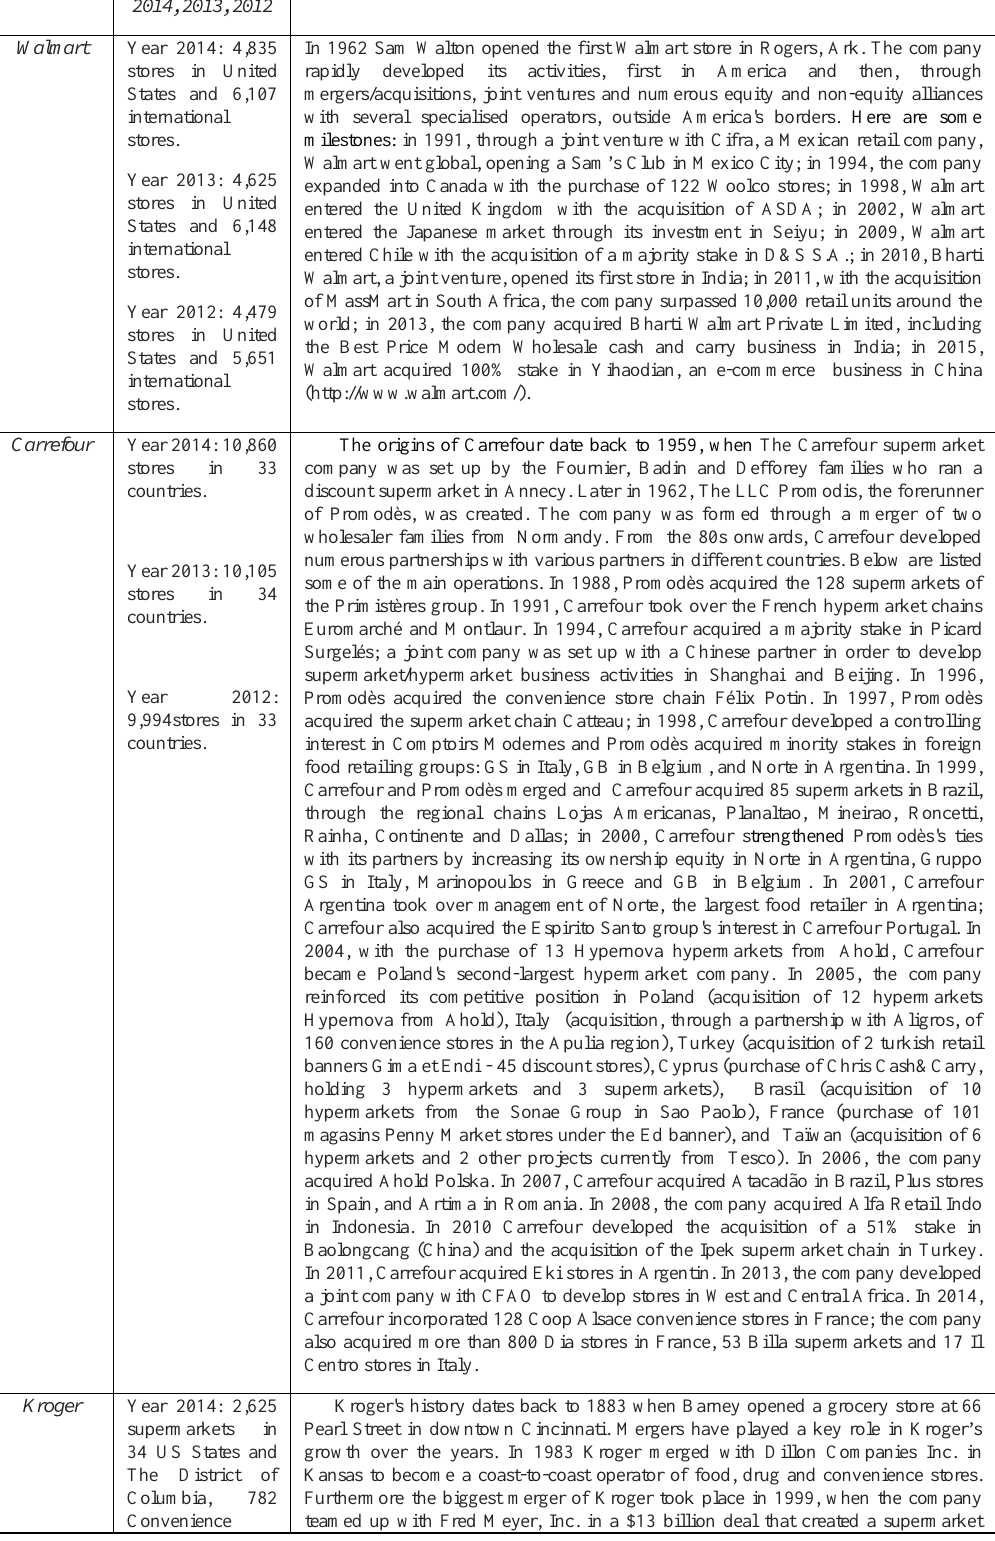
Table 3: Stores and some Alliances 1 of the three Largest Global Retailers Ranked by Revenue Stores – years 2014, 2013, 2012